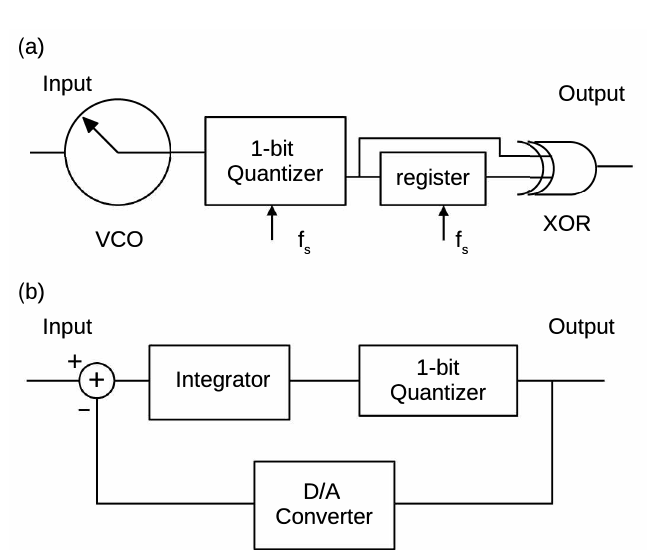
Figure 2. Block diagram of the delta-sigma modulators. ( a ) FDSM, ( b ) Conventional DSM.